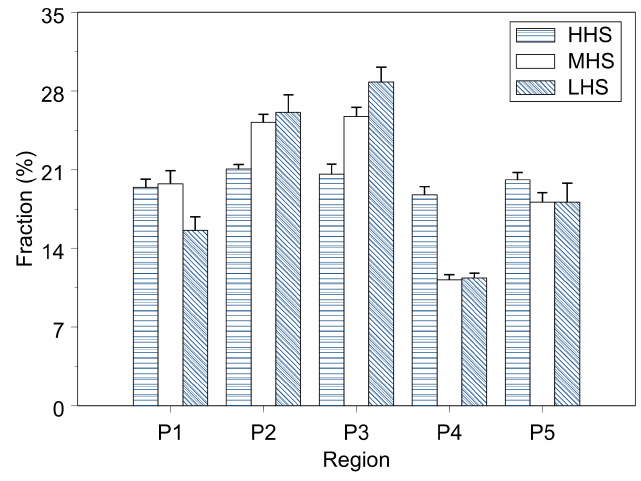
Figure 3. FRI percentages of size-fractioned SHS considering the AD and FD samples as pooled samples. The SUVA 254 and HIX had a negative correlation (r = − 0.41, p = 0.049). The SUVA 254 had a significantly positive correlation with the percentage of Bio fractions (r = 0.64, p < 0.001), but the HIX had a significantly positive correlation with the percentage of Geo fractions (r = 0.93, p <